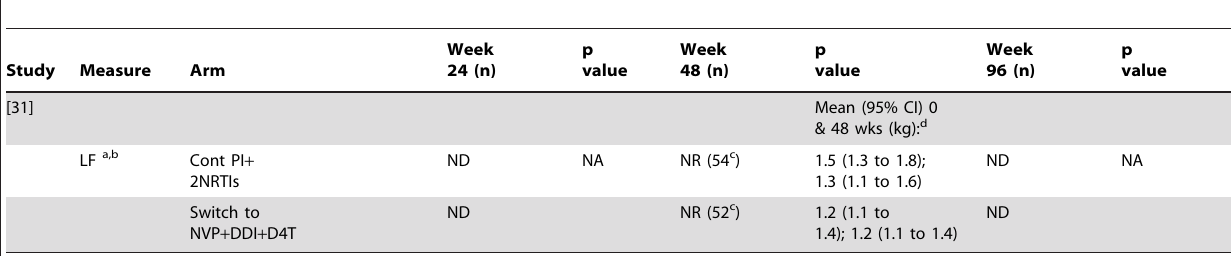
and VAT was similar in HIV-infected and control women, while HIV-infected men had less fat at all sites than control men. The gains in VAT over five years were similar in HIV-infected people and controls. Fat loss: changes in limb fat and SAT with different antiretroviral regimens. The changes from baseline in limb fat and SAT are summarised in Tables 2, 3, 4, 5, and 6, and the incidences of peripheral lipoatrophy (defined as $ 20% loss in limb fat) are summarised in Tables 7, 8, 9, 10, and 11. Table 18. Switching studies: change from baseline in limb fat (LF) on DEXA scan: PI versus NNRTI.